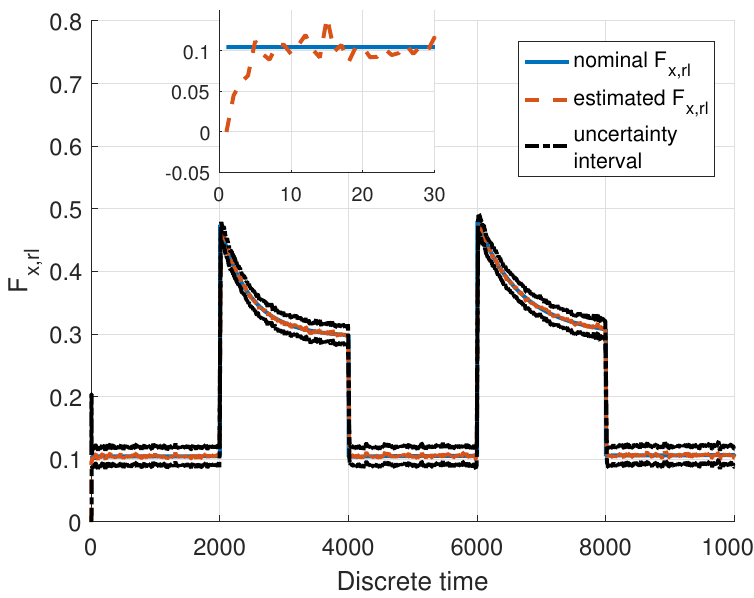
Figure 6. Nominal and estimated F x , rl .